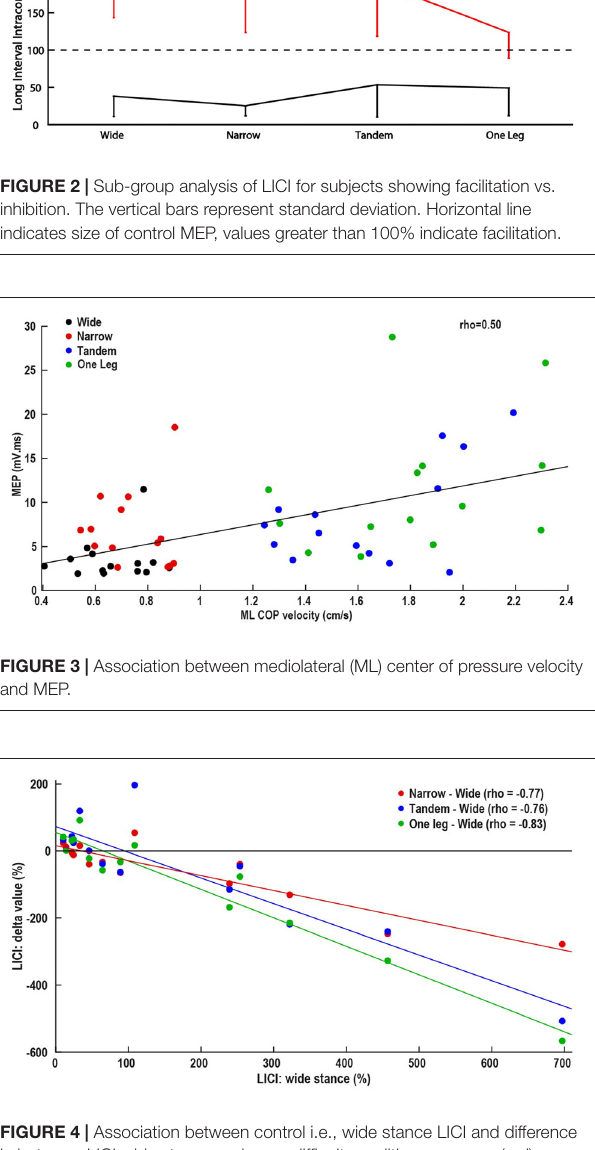
FIGURE 4 | Association between control i.e., wide stance LICI and difference in between LICI wide stance and more difficult conditions—narrow (red), tandem (blue) and one leg (green). Horizontal line represents no change in LICI, above line—decrease in LICI with increasing task difficulty, below line—increase in LICI with increasing task difficulty.